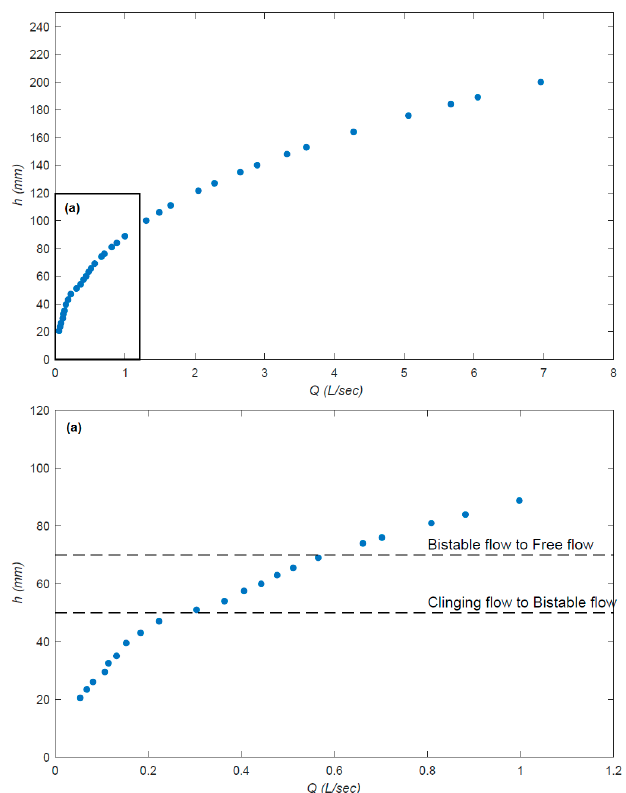
Figure 5. Observed Head ( h ) plotted against discharge ( Q ), and a closer look into the low values where transition points are marked ( a ).